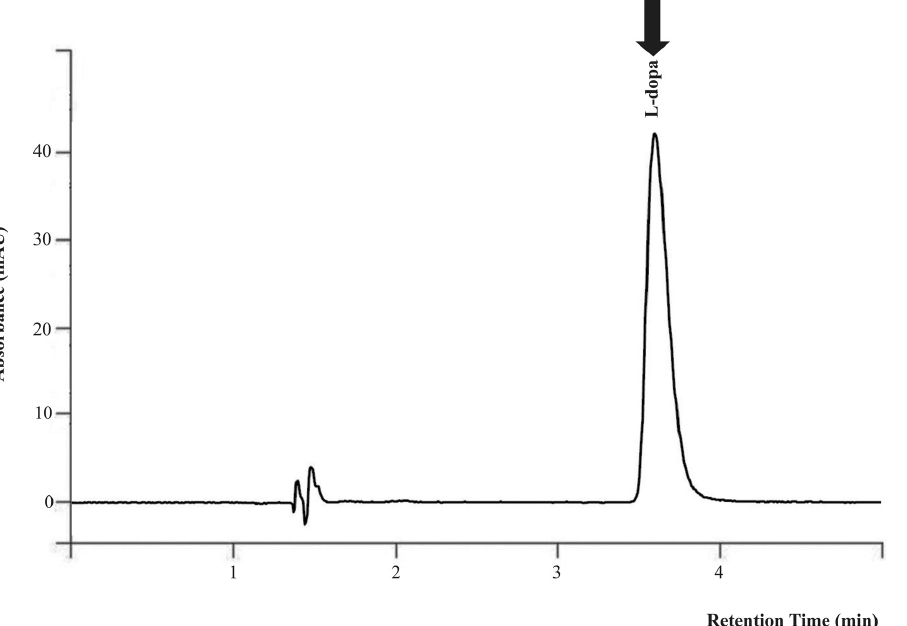
FIGURE 2 - Levodopa standard chromatogram obtained by high-performance liquid chromatography. The highest peak indicates the presence of levodopa.